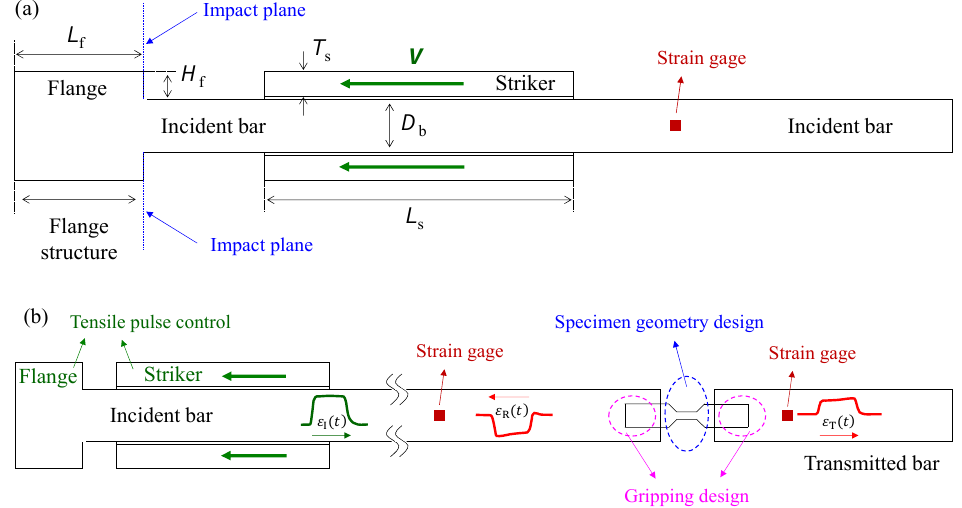
Figure 1. Schematic of: ( a ) hollow striker, flange, and incident bar ( L f : flange length, H f : flange height, T s : striker thickness, L s : striker length, D b : bar diameter, and V : impact velocity) and ( b ) the overall SHTB system, where ε I , ε R , and ε T denote the incident, reflected, and transmitted pulses, respectively, with time ( t ).